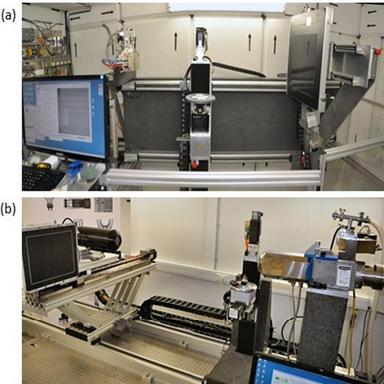
Micro-CT apparatus at UGCT (a) HECTOR (b) Medusa.